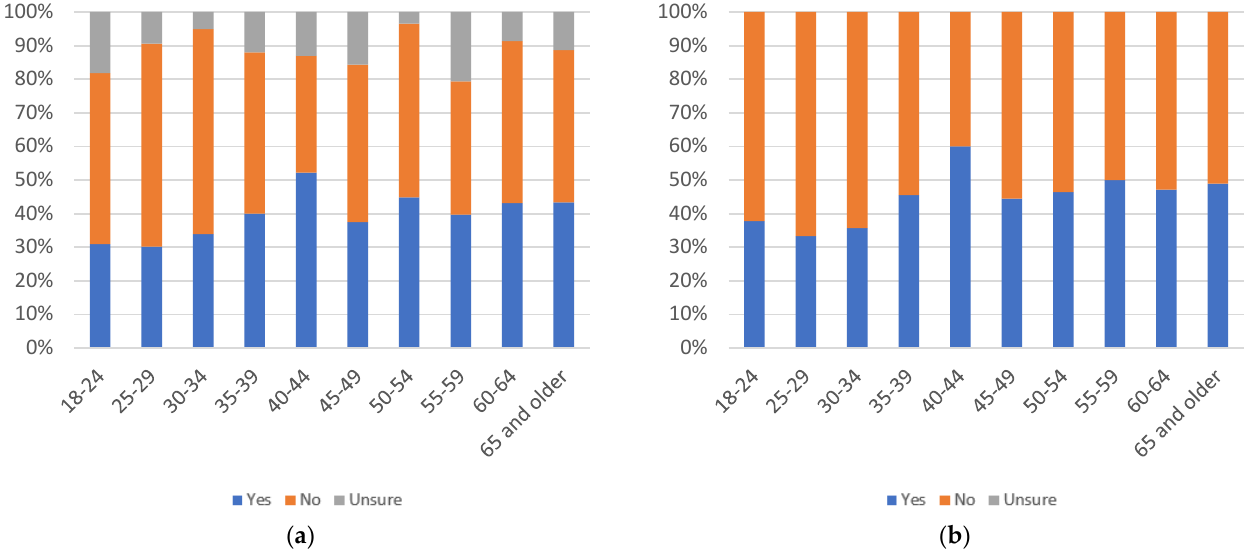
Figure 104. Label annoyingness, by age group: ( a ) with uncertain respondents (left) and ( b ) without uncertain respondents (right).